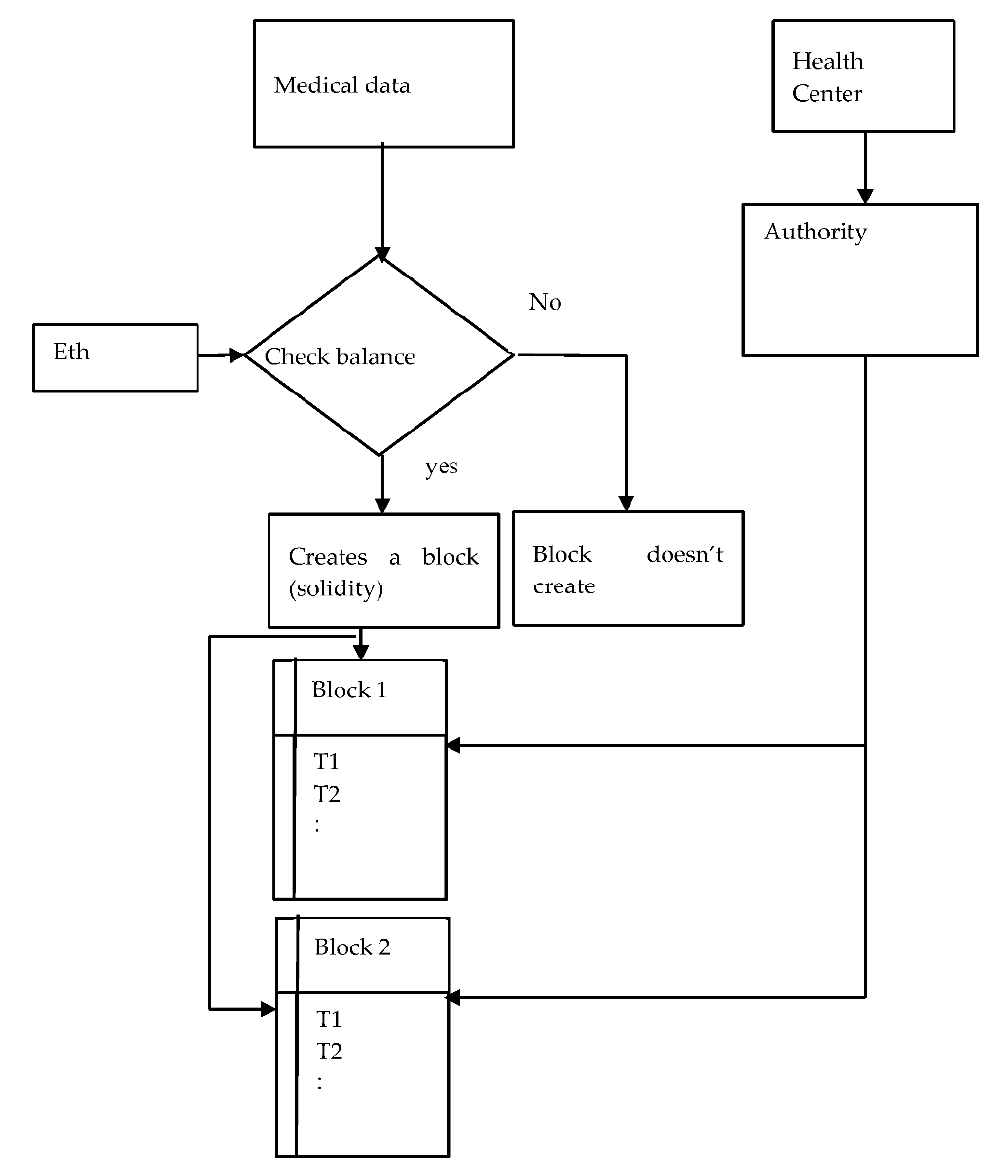
Figure 3. Medical data transaction creation over a blockchain.